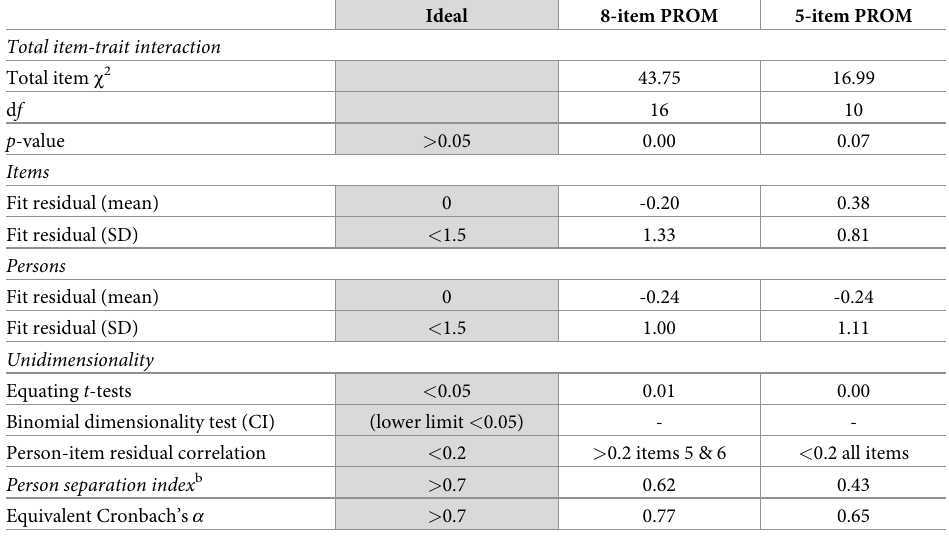
Table 3. Overall Rasch model fit statistics and reliability of an eight item and five-item cardiac PROM a .